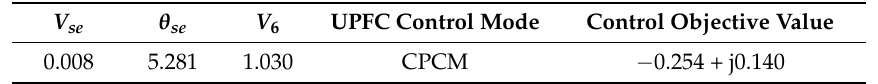
Table 8. The optimized parameters, control mode, and control objective value of UPFC in Case B.